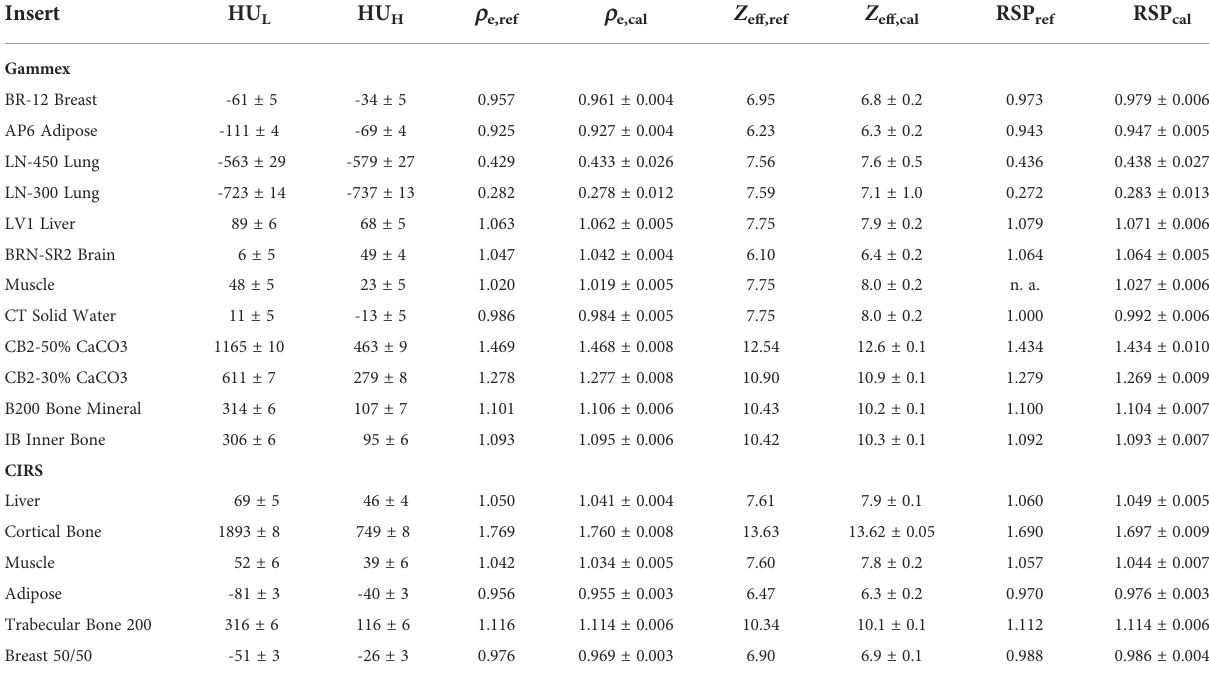
TABLE 4 Mean and standard deviation of CT numbers for Gammex and CIRS inserts from 60 keV (HU L ) and 180 keV (HU H ) VMIs, along with the mean and standard deviation of the calculated RED ( r e,cal ), EAN ( Z eff,cal ), and RSP values for all inserts.